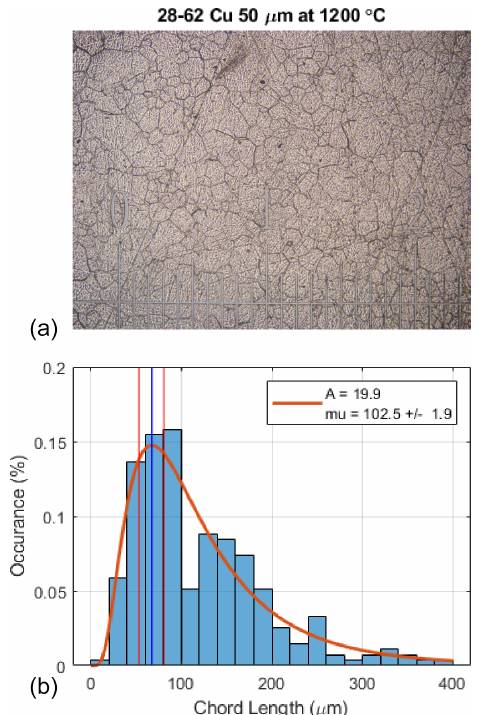
Figure 8. (a) Photograph of 50µm 6-81Mo permalloy coupon heat treated at 1200 ◦ C. Major increments in the graticule show 1mm spacing. (b) Distribution of chord lengths (proxy for grain size) as determined visually using the intercept